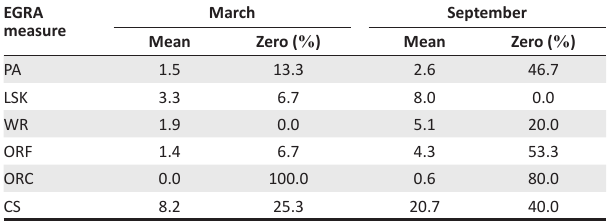
TABLE 7: Descriptive statistics for T4 classroom in school